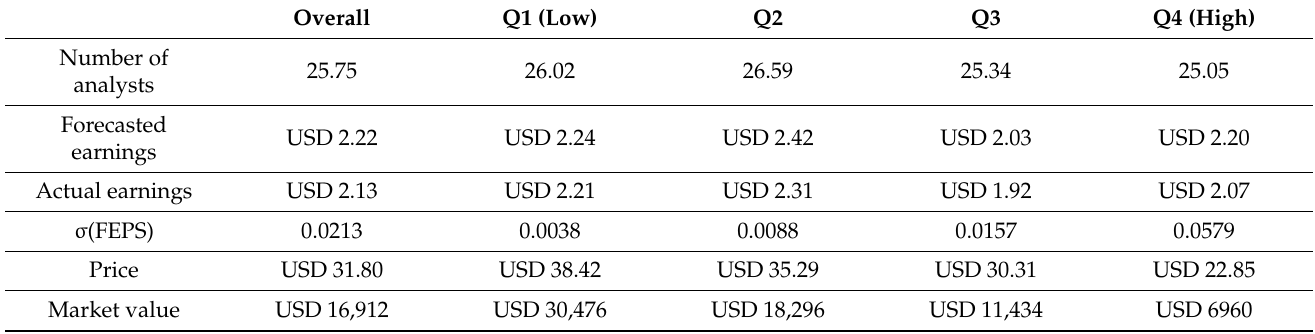
Table 4. Summary statistics for bull and bear years. The table reports summary information for our sample, which includes data from January 1980 through December 2018. In addition to full sample information, Panel A provides sample statistics for bull-market years and quartiles based on the standard deviation of analysts’ forecasts scaled by price ( σ (FEPS)), and Panel B reports information for bear-market years and quartiles based on market value (MV). First, the table reports the number of analysts following sample firms as reported in the IBES database. Next, the table reports on forecasted and actual earnings, σ (FEPS), stock price, and market value (in millions of dollars). Panel A: Means for the Bull-Market Years and Quartiles Determined by the Standard Deviation of Analysts’ Earnings Forecasts Scaled by Price ( σ